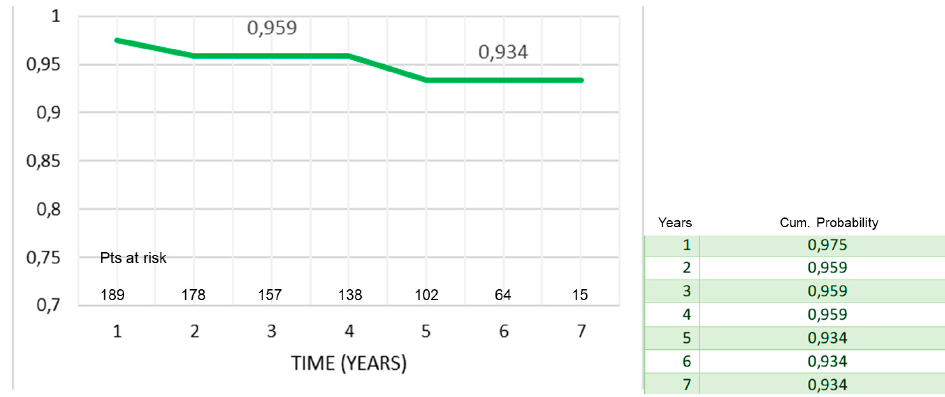
Figure 1. Survival after Bentall operation (mean follow-up, 55 ± 24 (M 60.2) months).